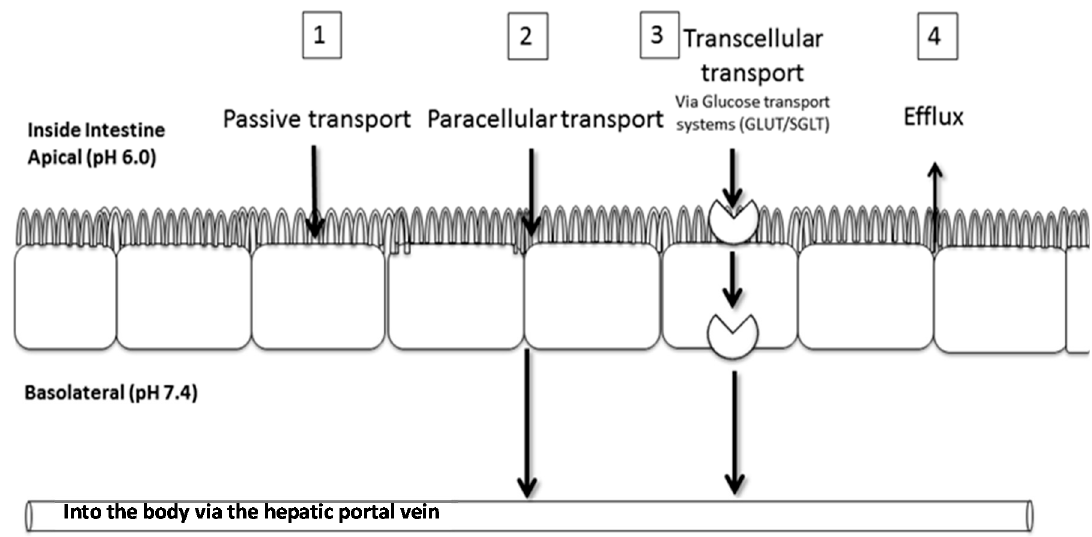
Figure 1. Possible transport pathways of aspalathin across the intestinal epithelium, namely ( 1 ) passive transcellular; ( 2 ) paracellular; ( 3 ) active carrier-mediated and transcytosis; as well as ( 4 ) carrier-mediated efflux (Adapted from http://www.sddu.leeds.ac.uk/gts/postgrad/resources/poster/ Courts.pdf, detailed in [3]).